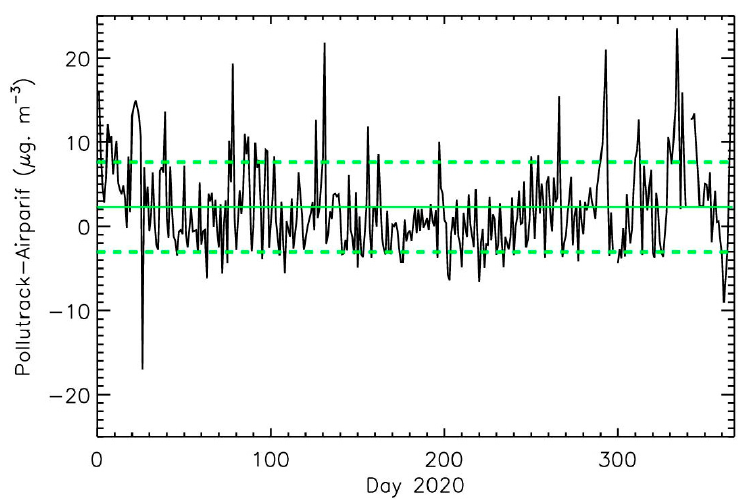
Figure 7. Black line: difference between Pollutrack and Airparif daily averaged PM2.5 measurements Full green line: mean; green dashed line: standard deviation.